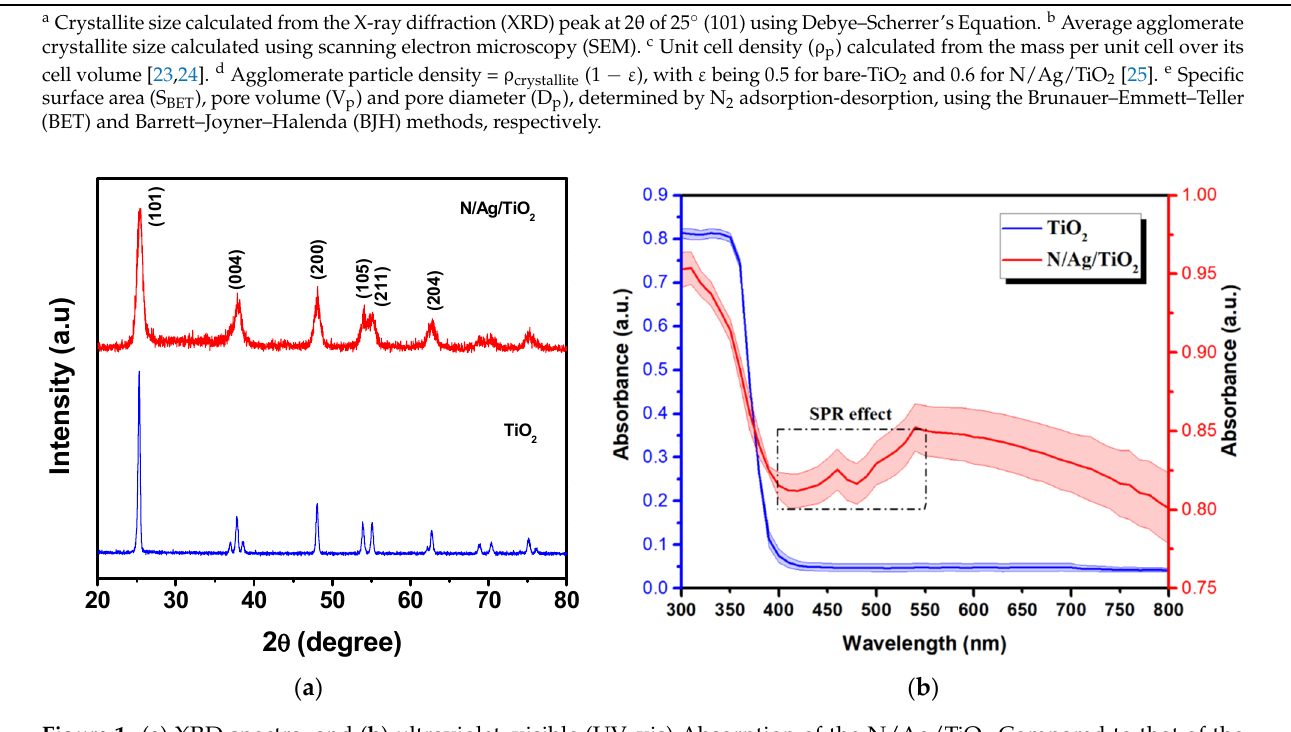
Figure 1. ( a ) XRD spectra, and ( b ) ultraviolet–visible (UV–vis) Absorption of the N/Ag/TiO 2 Compared to that of the bare-TiO 2